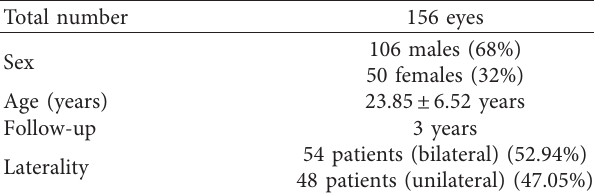
Table 1: Demographic data of the